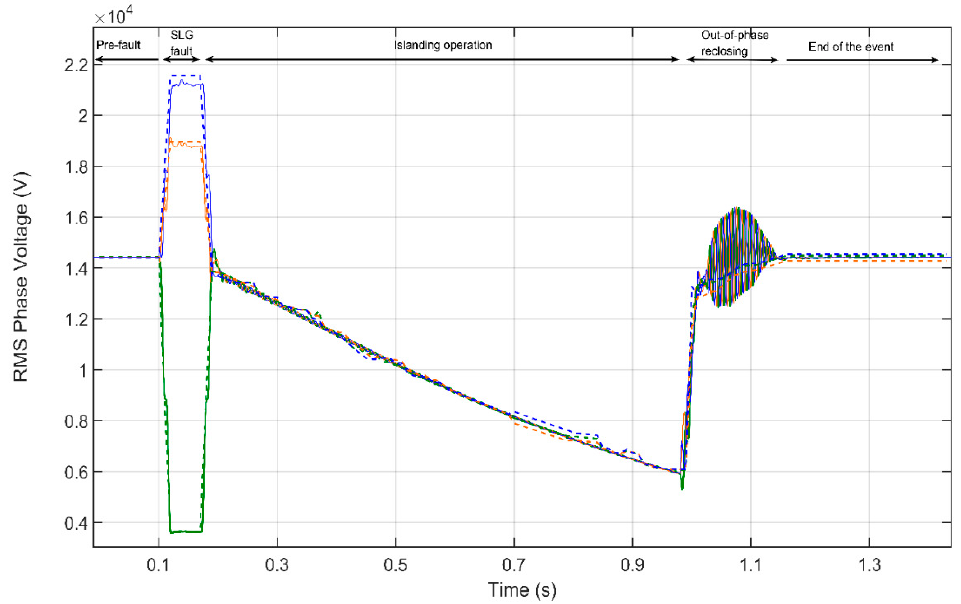
Figure 13. Event II comparison. Solid (simulation) / dashed (measurements): orange (Phase A), blue (Phase B) and green (Phase C).